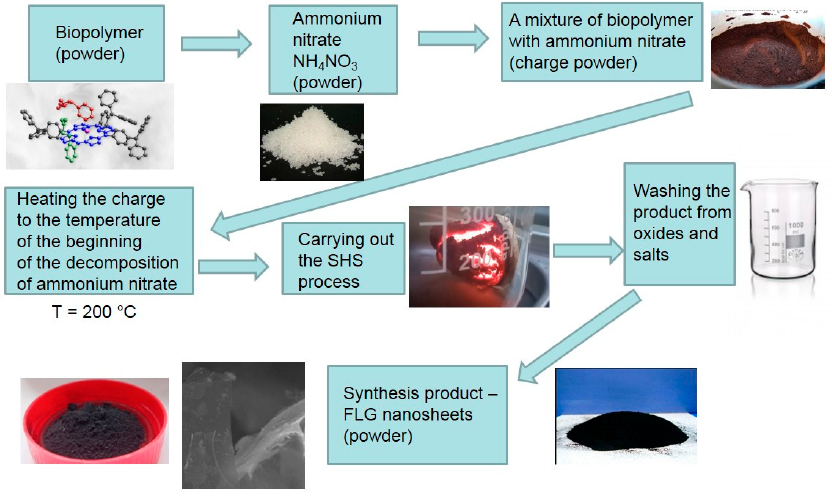
Figure 1. Process Figure 1. Process flowchart.